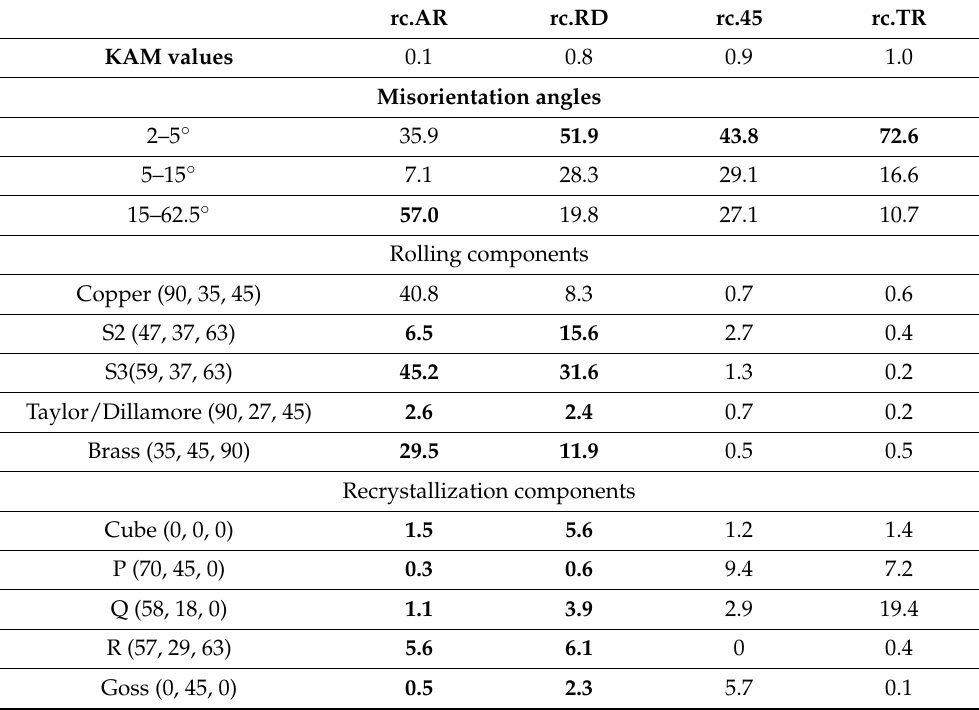
Table 5. KAM values, misorientation, and texture components of the recovered sheet sample.